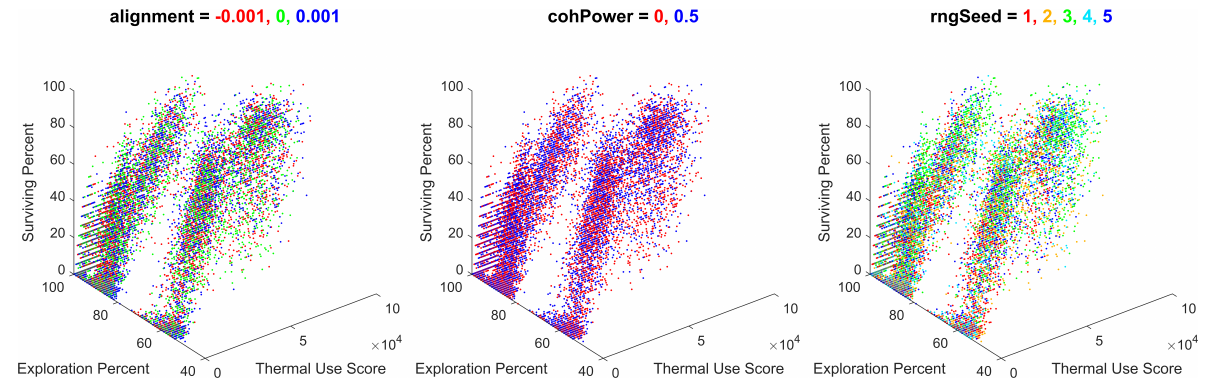
Figure 18. All batch simulation data plotted for thermal use, exploration percentage, and survival percentage, colored for alignment values of − 0.001 and 0, 0.001, cohesion power values of 0 and 0.5, and random number generator seeds of 1, 2, 3, 4, or 5. Note the lack of any identifiable trend between the results and each unique value for the alignment, cohesion power, and RNG